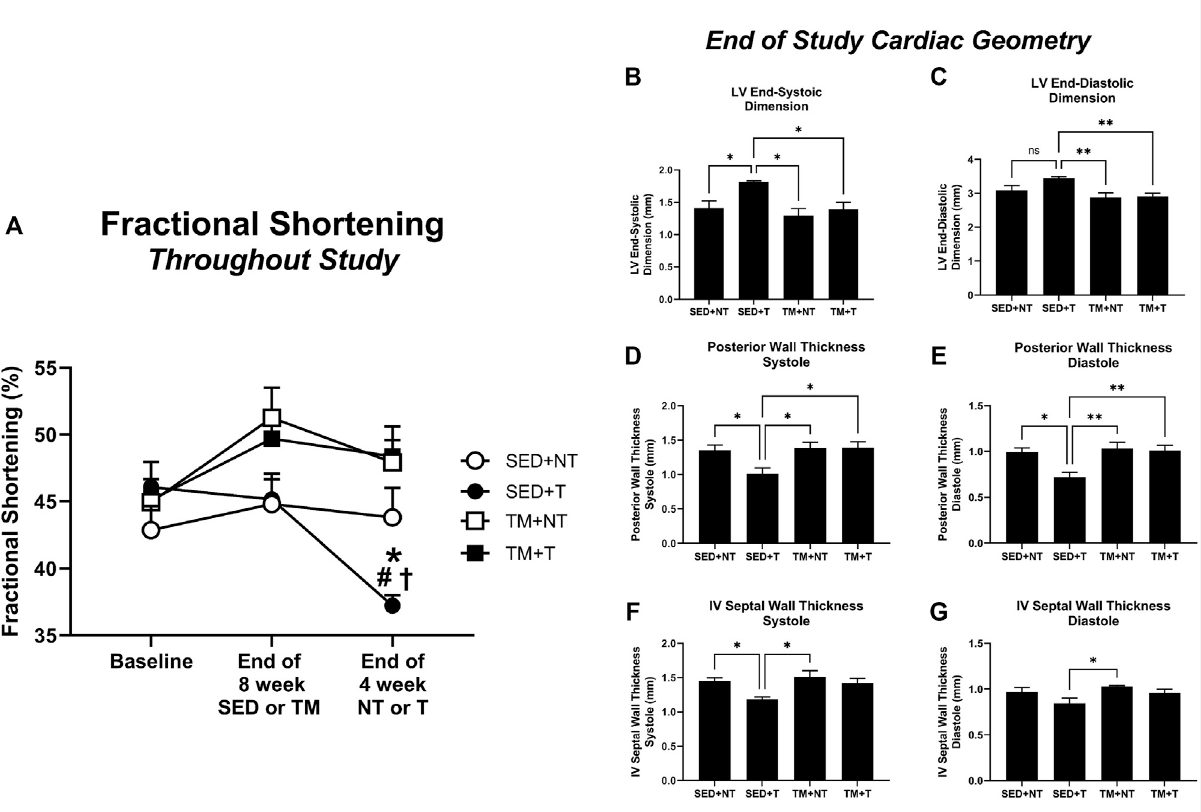
FIGURE 3 Cardiac Function. Tumor bearing results in a signi fi cant decline in cardiac function, thinning of walls, and enlarged left ventricle chamber size. Preconditioning endurance treadmill exercise preserves cardiac function in tumor-bearing animals based on fractional shortening analysis. SED, sedentary; TM, preconditioning treadmill endurance exercise training; T, tumor bearing; NT, non-tumor. Data are presented as mean ± SD. (A) * p < 0.05 vs SED + NT, # p < 0.05 vs TM + NT, † p < 0.05 vs TM + T. (B – G) , * p < 0.05, ** p <